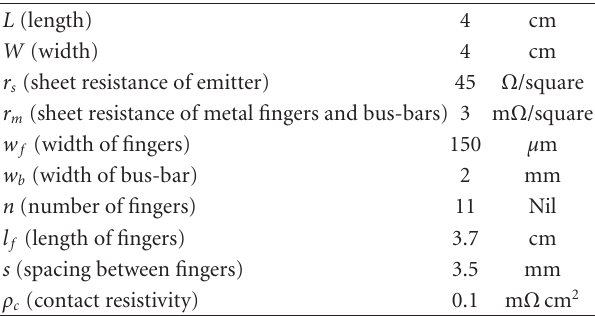
Figure 1: Resistance network of the solar cells ( R bus Bus-bar resistance, R m metal line resistance consisting of metal finger resistance, R f and metal finger to semiconductor contact resistance, R fc , R emitter Emitter resistance, R bulk Bulk resistance). Table 1: Geometrical parameters used in the